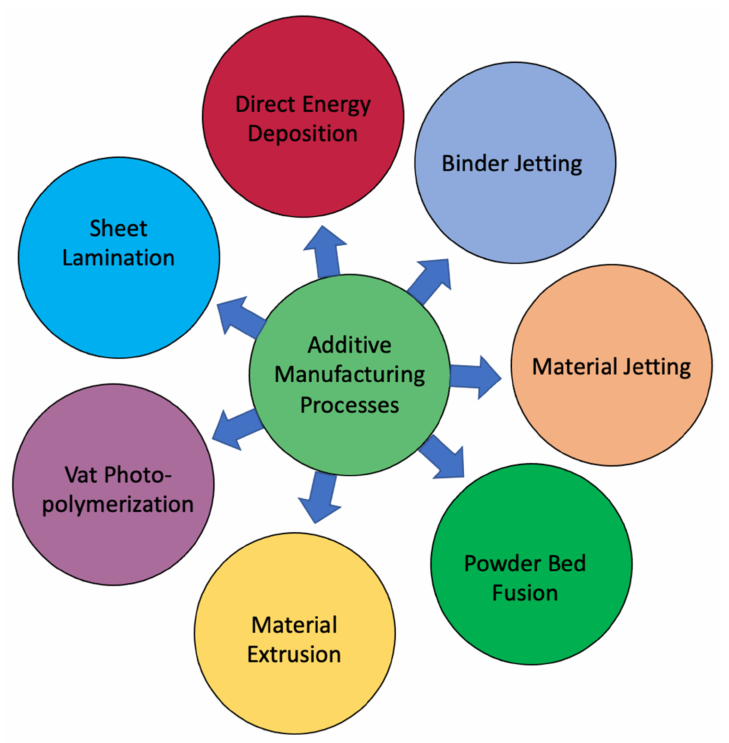
Figure 1. Classification of a typical AM